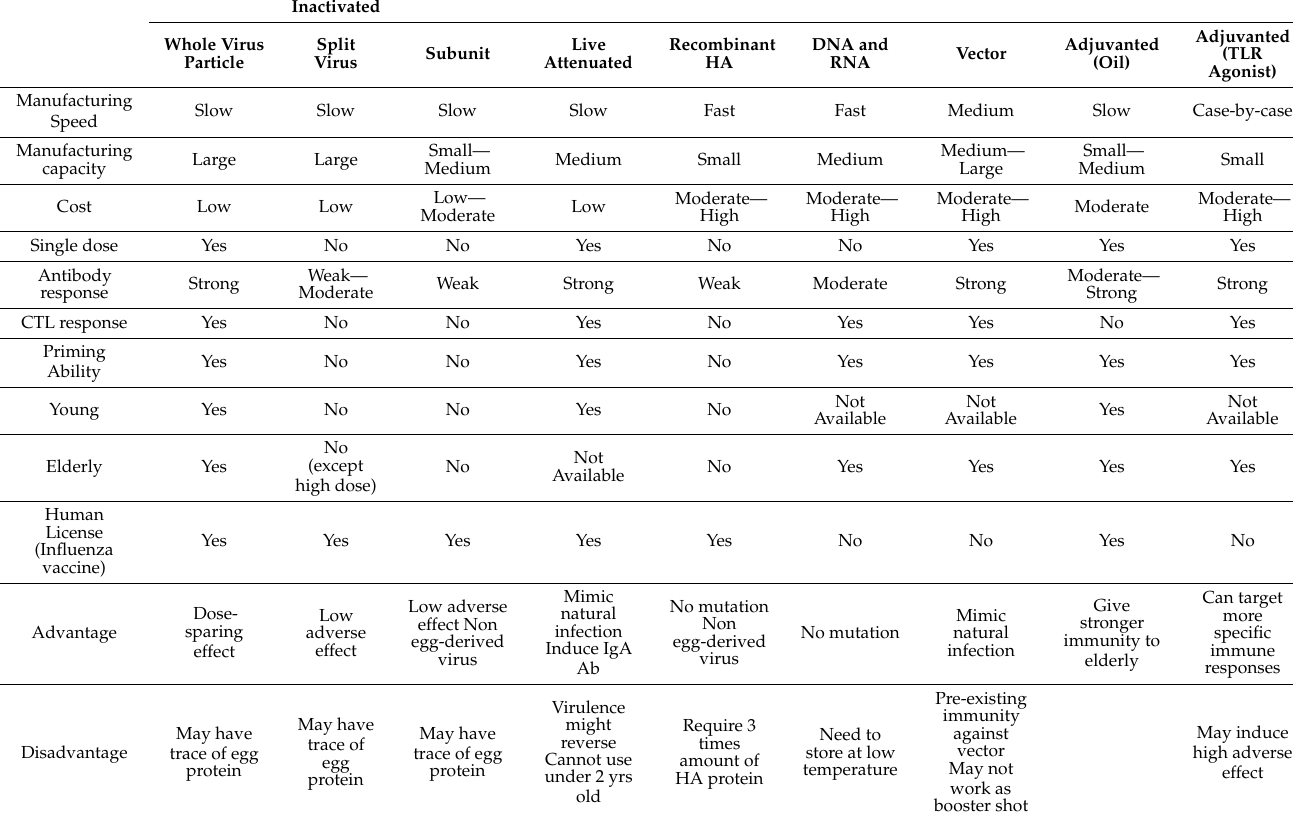
Table 2. Each Vaccine platform’s advantages and